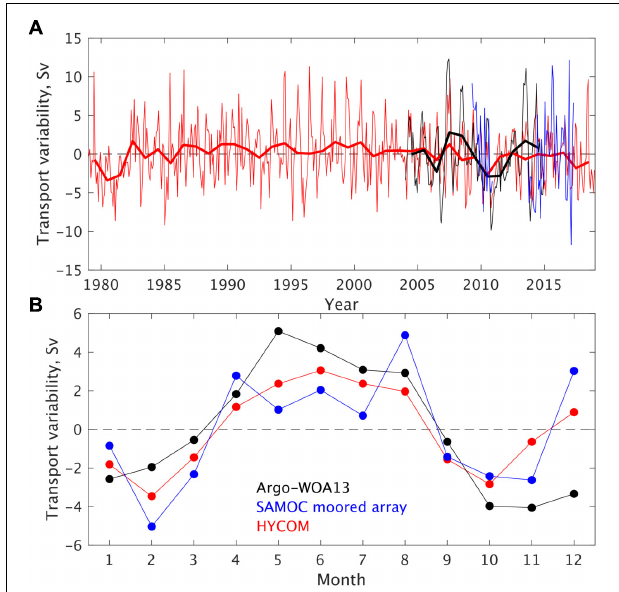
FIGURE 6 | (A) Time series of the AMOC transport variability (in Sv) at 34 ◦ S based on Argo-WOA13 (black, Dong et al., 2014), SAMOC-mooring array (blue, Meinen et al., 2018), and global HYCOM (red). The thin and thick lines represent monthly means and 12-month moving averages, respectively. (B) AMOC transport variability at seasonal timescale, with each dot representing the multi-year average of the monthly AMOC